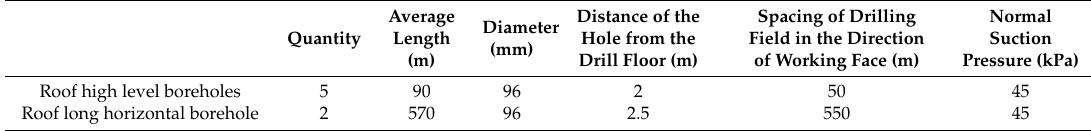
Table 2. Comparison in drilling parameters for gas drainage between long horizontal borehole and high level boreholes. Average Quantity